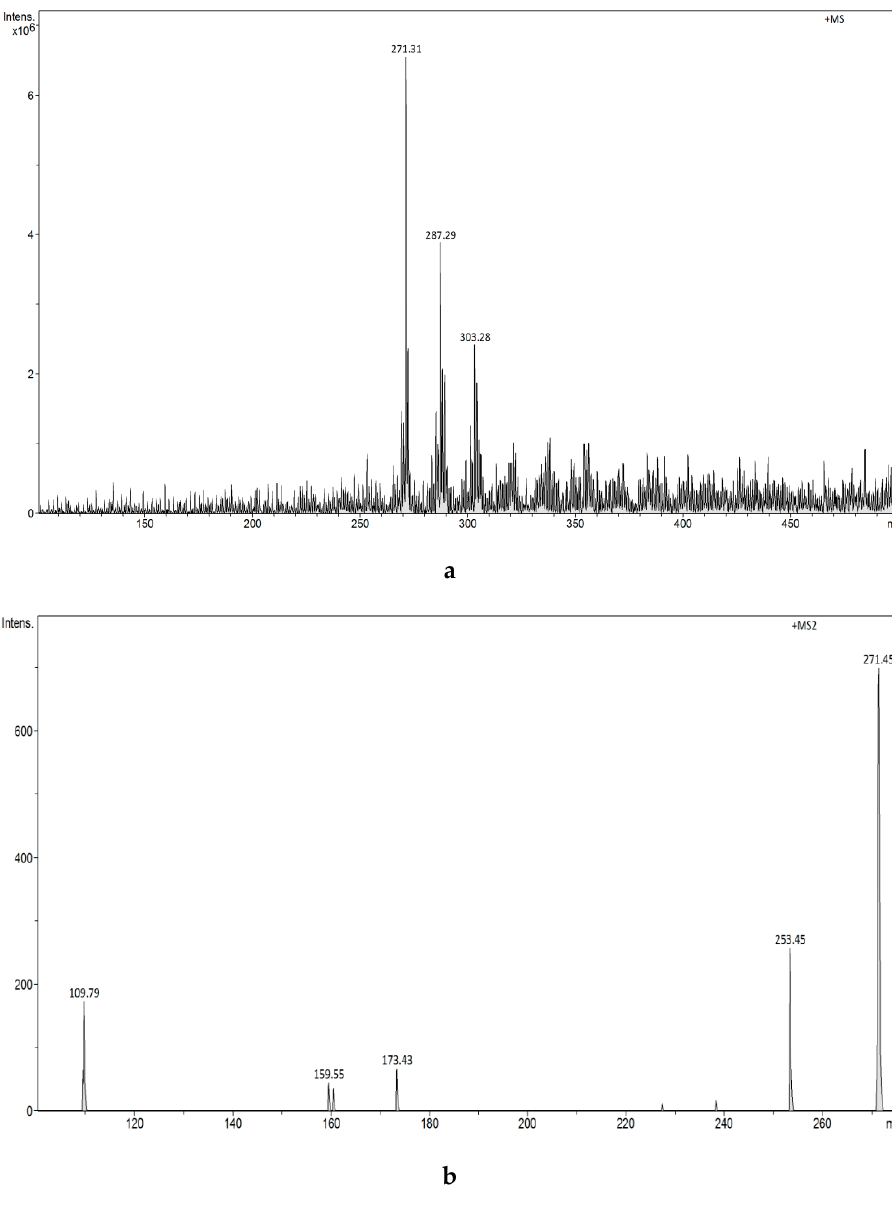
Figure 12. ( a ) FAPA-MS (positive ions) spectrum of E1 from E1-mag-MIP. ( b ) FAPA-MS 2 fragmentation spectrum of the m/z 271 ion observed for E1 from E1-mag-MIP.